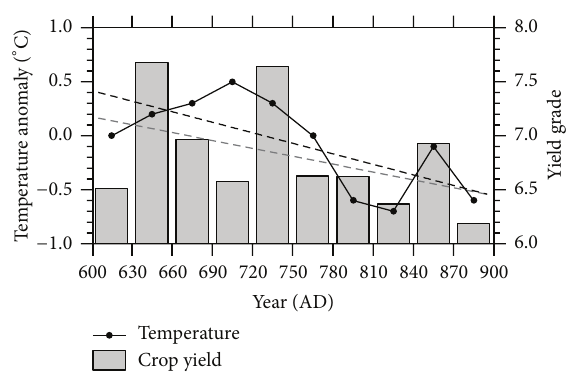
Figure 3: Reconstructed temperature series for 601–900 AD (referred to the mean of 1951–1980 AD) covering Central East China [20]andregionalmeancropyieldforeachofthe30yearsofthestudy area (black-dashed line and gray-dashed line denote linear trend of temperature and crop yield,